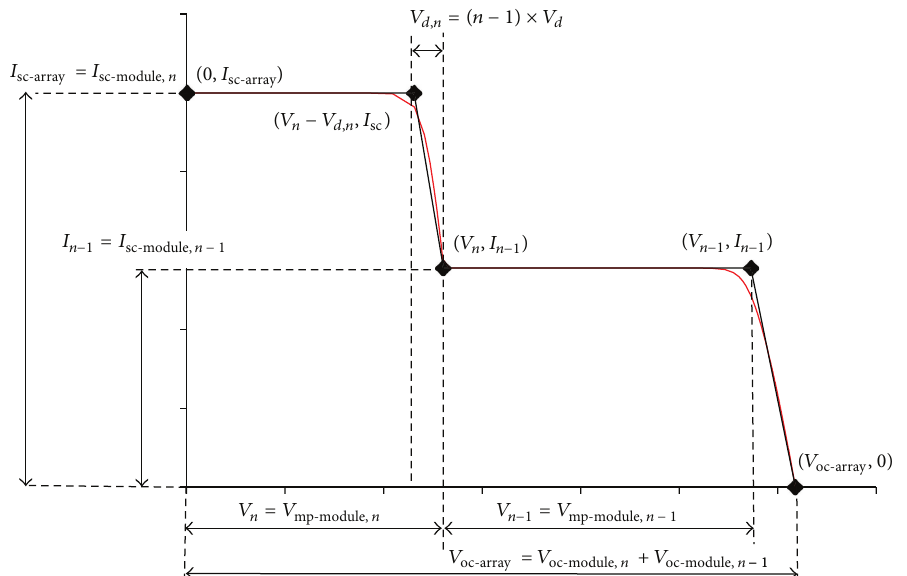
Figure 9: This figure shows critical points of the new approximation model (black line), with two series-connected string in an array ( 𝑛 = 2 ).